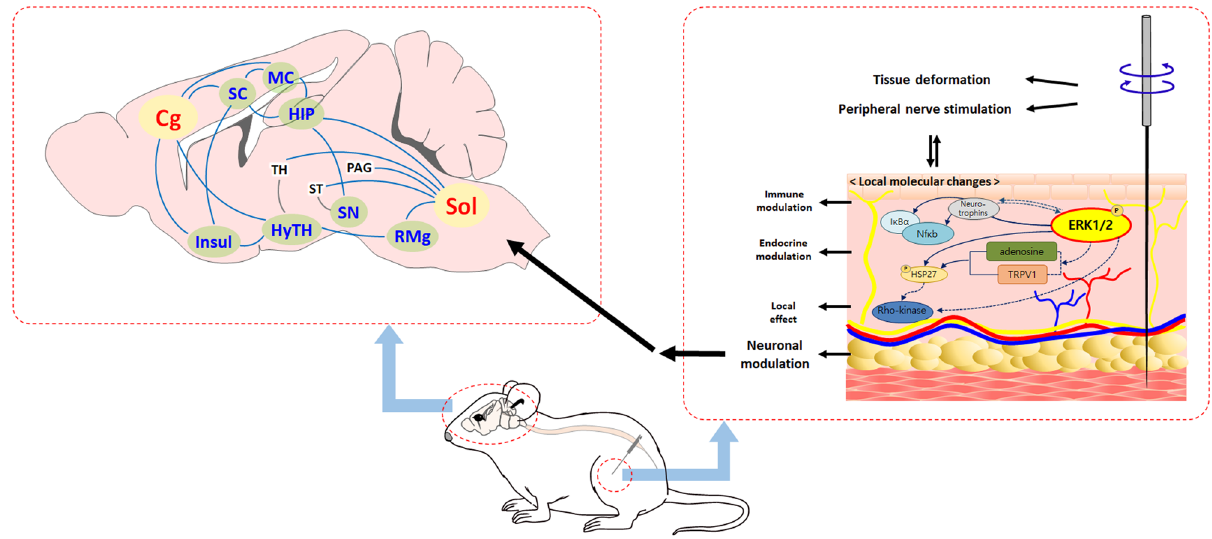
Figure 7. Schematic diagram of local molecular signaling and brain function after acupuncture treatment. The peripheral mechanism (right) and central mechanism (left) after acupuncture treatment are illustrated. Acupuncture-induced ERK1/2 activation acts as a triggering molecule that induces multiple signaling transduction around the acupoint. These local signals are received by the peripheral nerve ending and then transmitted to the afferent sensory nervous tract. The brain regions of Sol and Cg are mainly involved in acupuncture-mediated brain functional connectivity, and these brain regions are functionally connected with variable brain regions of SC, MC, HIP, Insul, HyTH, SN, and RMg. These central signals might activate the descending inhibitory pathway that provokes the acupuncture effect. The solid line is the mechanism of the findings in this study, and the dotted line is the potential prediction mechanism. Cg cingulate cortex, Insul insular cortex, HIP hippocampus, HYTH hypothalamus, MC motor cortex, PAG periaqueductal grey, RMg raphe magnus nucleus, SC somatosensory cortex, SN substantia nigra, Sol nucleus of solitary tract, ST striatum, TH